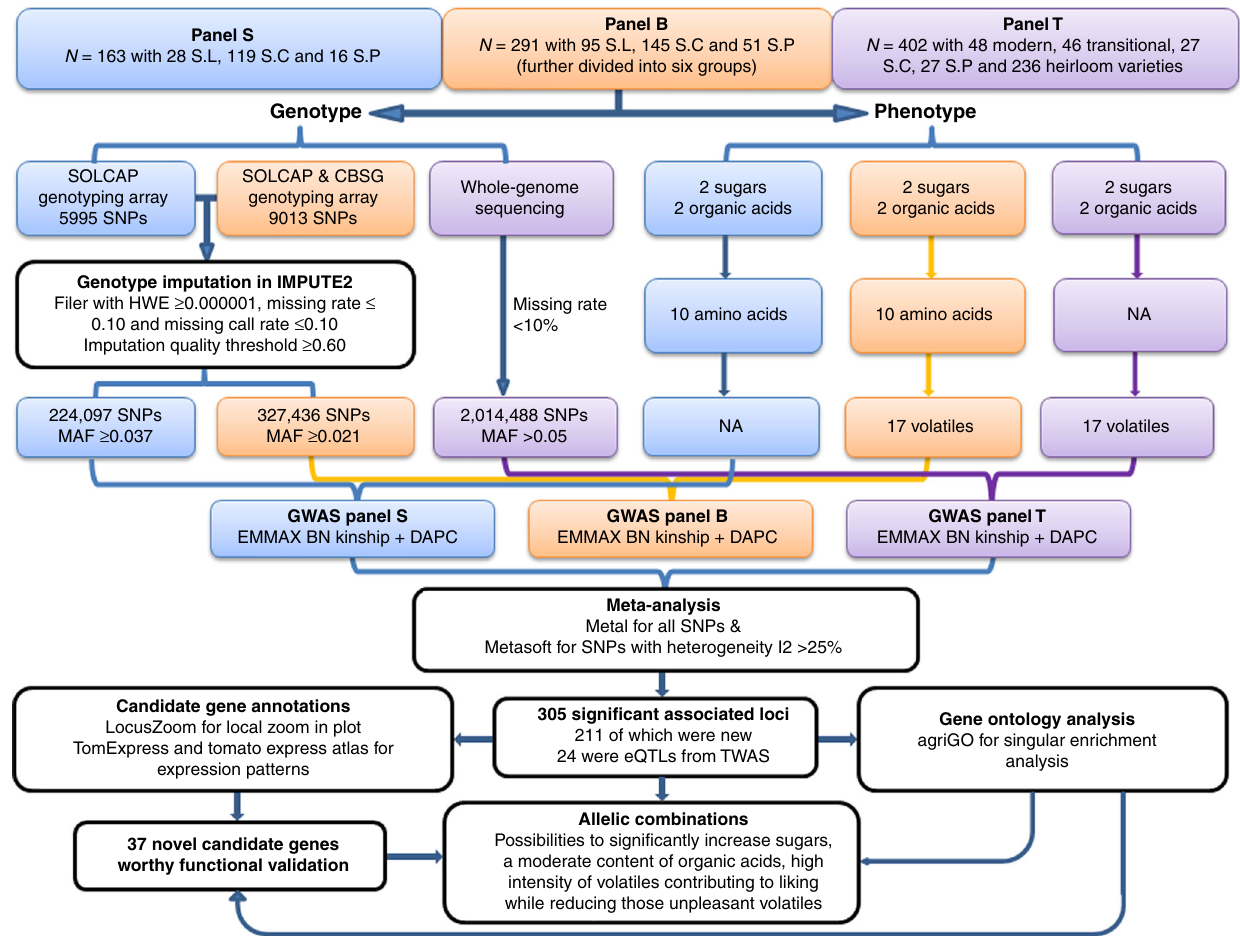
Fig. 1 Overview of study design. N, the number of individuals; S.L, S. lycopersicum ; S.C, S. lycopersicum var cerasiforme ; S.P, S. pimpinellifolium ; Genotyping arrays: SOLCAP, Solanaceae Coordinated Agricultural Project; CBSG, Centre of Biosystems Genomics consortium; HWE, Hardy – Weinberg equilibrium; MAF, minor allele frequency; GWAS, genome-wide association study; EMMAX, Ef fi cient Mixed-Model Association eXpedited; DAPC, Discriminant Analysis of Principal Components; eQTL, expression quantitative trait locus; TWAS, transcriptome-wide association